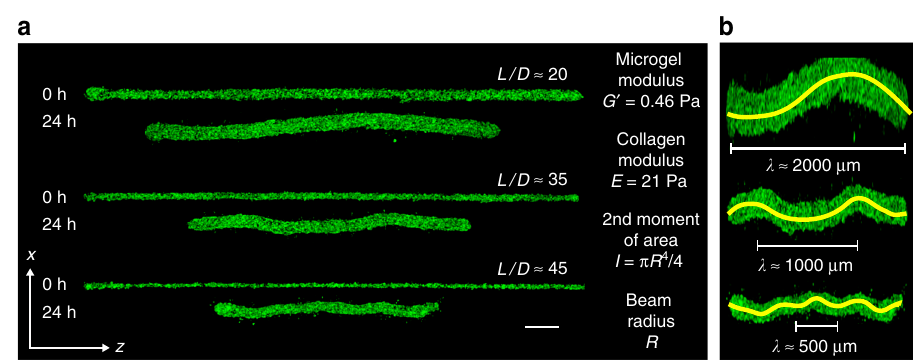
Fig. 2 3D printed microbeams made from cells and ECM appear to buckle. a 3D printed cell – ECM microbeams having lengths L = 5 mm and varying diameters, D , develop undulations over a 24 h period (Scale bar: 250 μ m). b Digitally stretched images of beams from ( a ) accentuate the undulations and reveal a relationship between beam radius, R , and wavelength, λ (lines